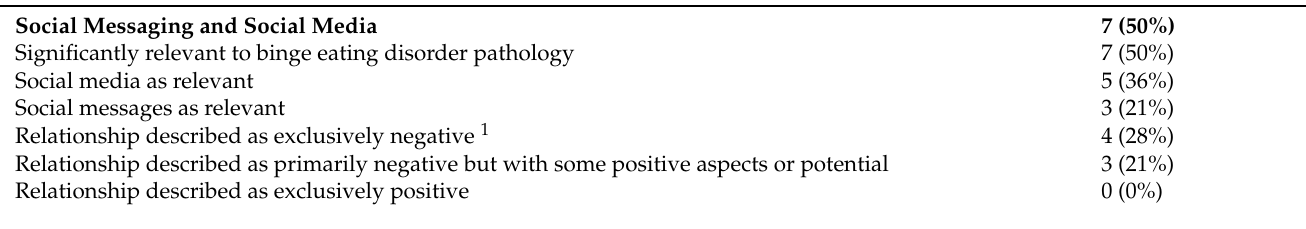
Table 10. Participant statements relating to Theme 7, “social messaging and social media”.